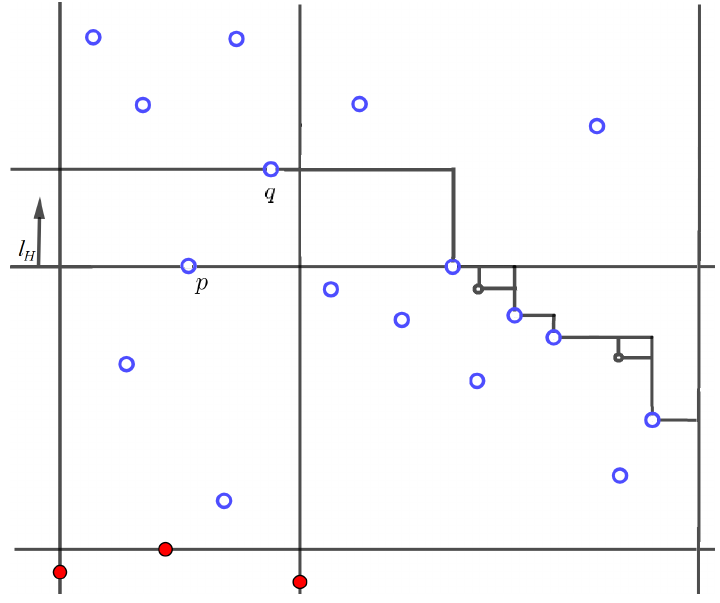
Figure 9. Case 6. p ∈ B N , q ∈ B N